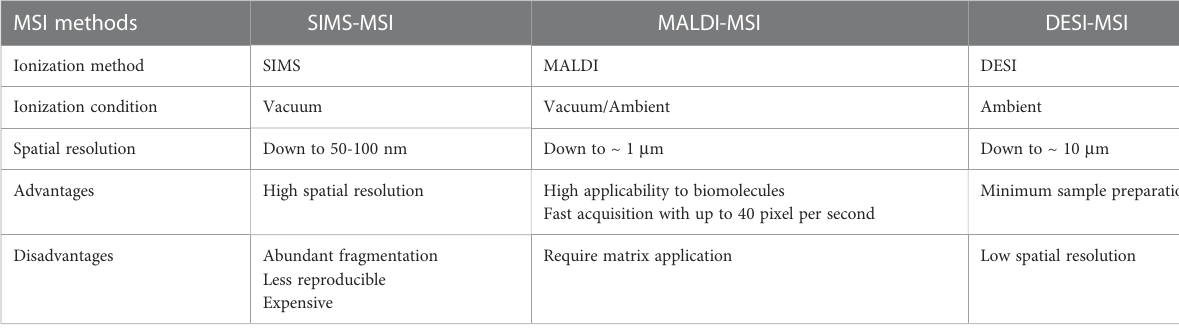
TABLE 1 Advantages and disadvantages of SIMS-MSI, MALDI-MSI and